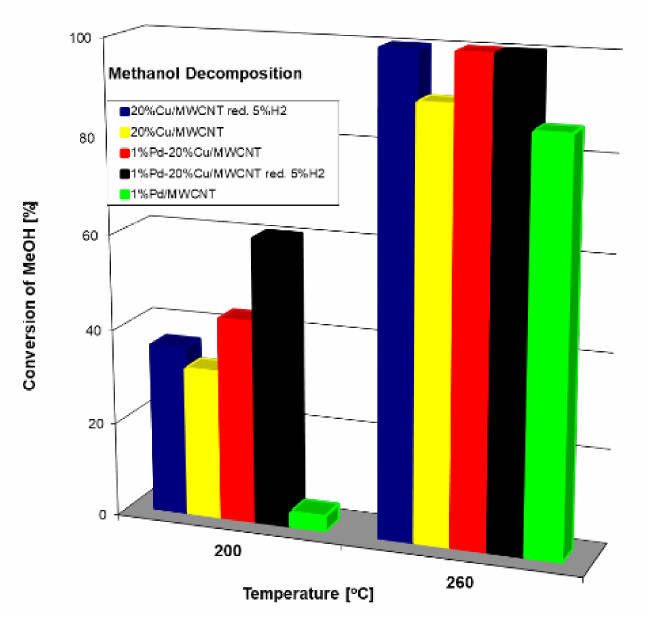
Figure 5. The methanol conversion results obtained for the monometallic and bimetallic catalysts during the methanol decomposition